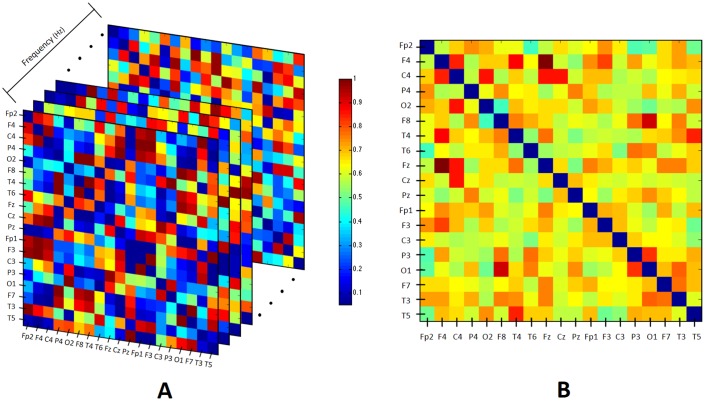
An example of the coherence spectrum matrix for one HA participant is shown in A, while B depicts the average coherence matrix that resulted from the coherence spectrum matrix integration from 0.5–30 Hz.